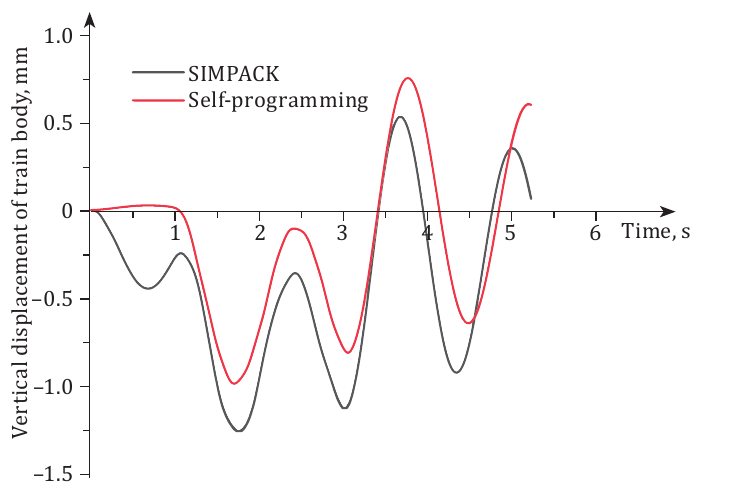
Figure 11. Comparison of vertical displacement time history at the vehicle